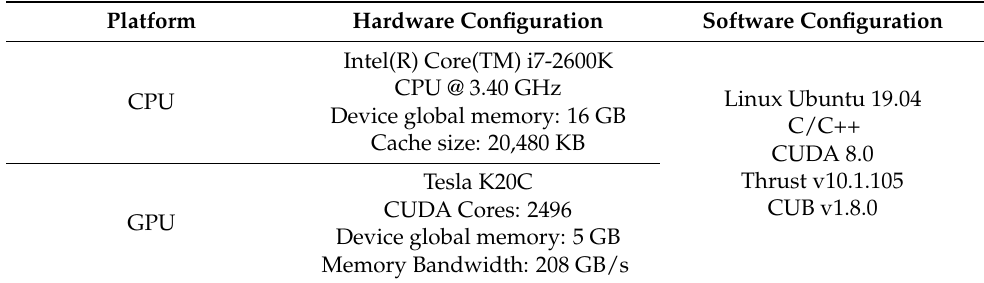
Table 1. Hardware and software configurations.